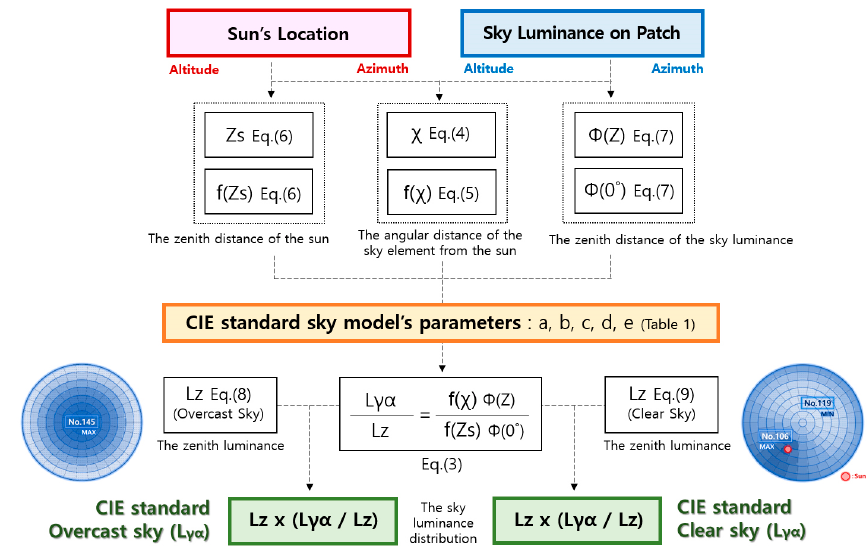
Figure 3. Algorithm framework of sky luminance distribution.